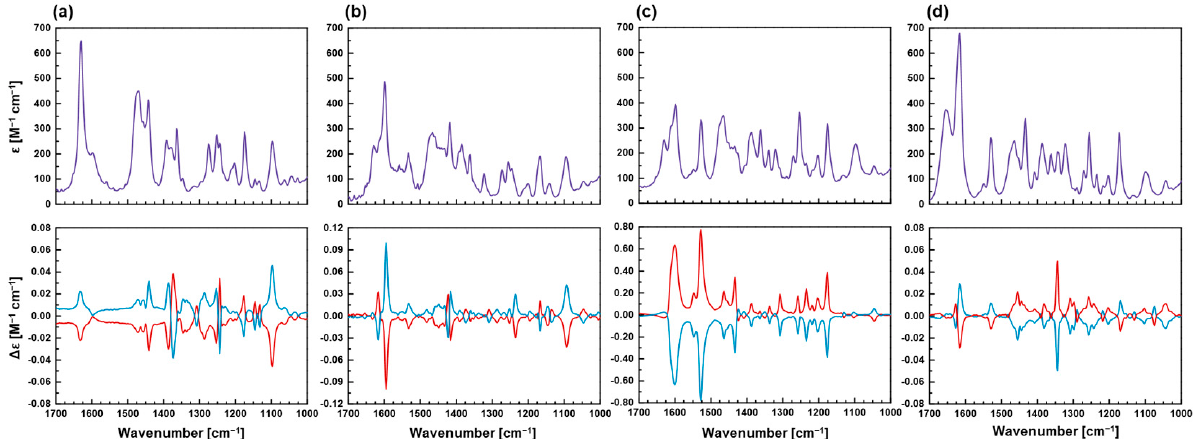
Figure 6. Solution (CDCl 3 ) IR (top, purple line, obtained using equimolar concentrations of both hands) and VCD (bottom) spectra of ( a ) L S,S H 2 and L R,R H 2 , ( b ) Zn(L S,S ) and Zn(L R,R ), ( c ) Co(L S,S ) and Co(L R,R ), and ( d ) Co(NO)(L S,S ) and Co(NO)(L R,R ). The L S,S - and L R,R -based systems are colored blue and red, respectively.